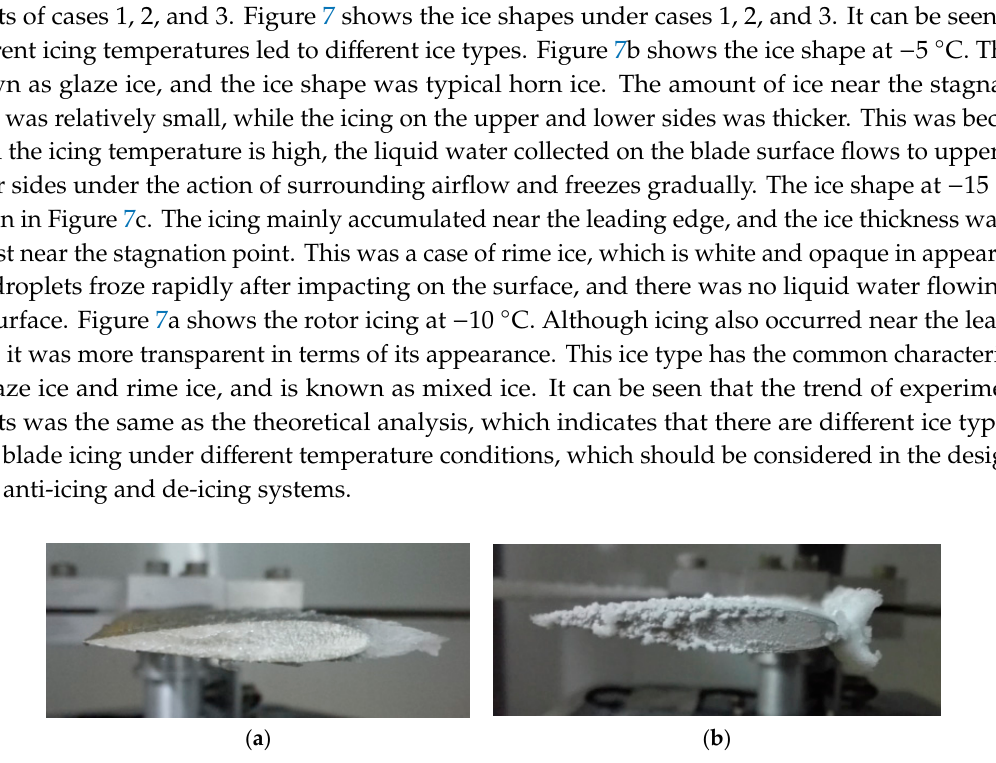
Figure 6. Ice shape of rotor blade.